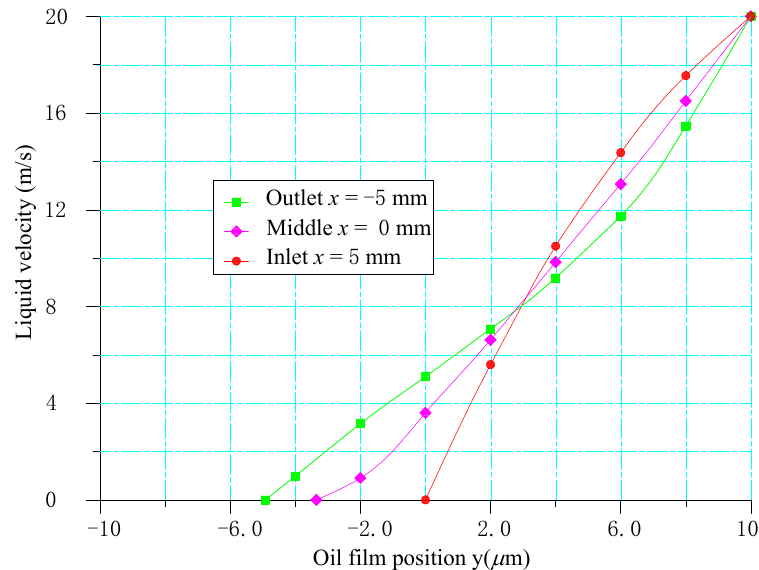
Figure 6. Velocity distribution along the thickness of the oil film.